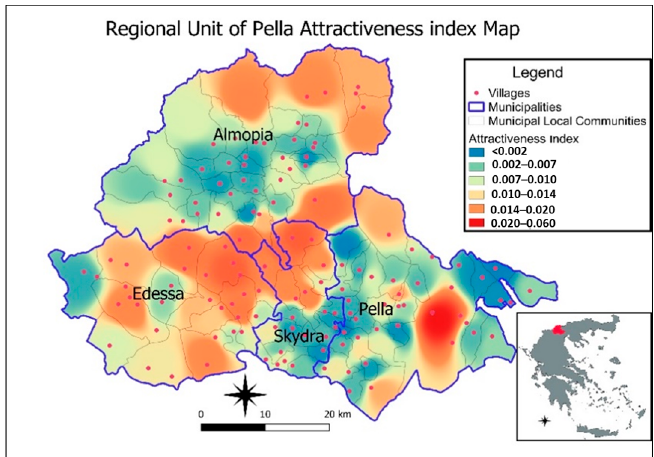
Figure 1. Relative Attractiveness Map (RAI) for year 2018.